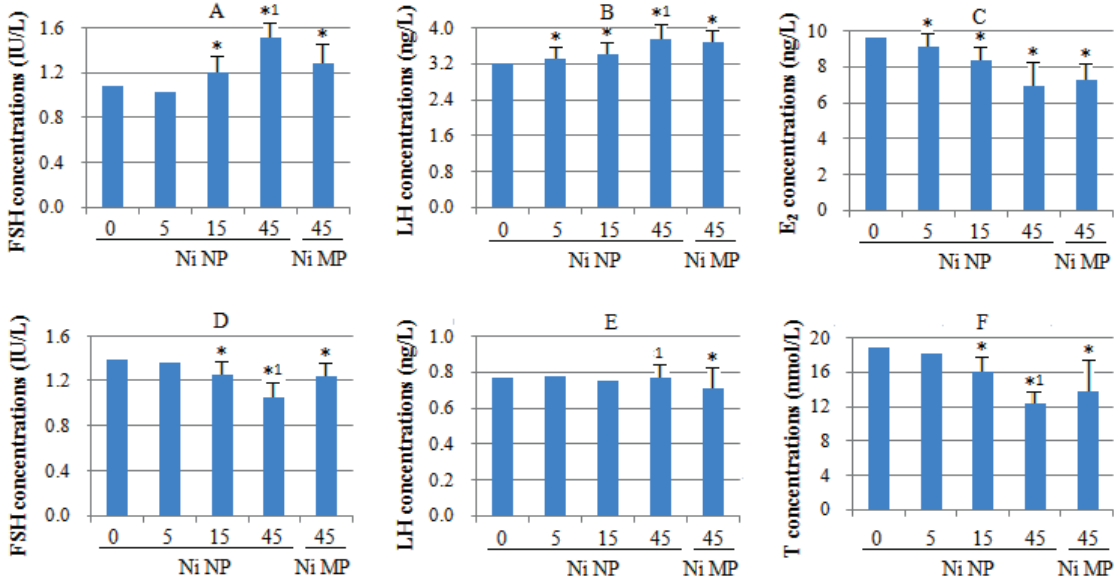
Figure 2. Effects of Ni NPs on serum hormone concentrations in rats. Follicle stimulating hormone (FSH) in females ( A ); Luteinizing hormone (LH) in females ( B ); Estradiol (E 2 ) in females ( C ); FSH in males ( D ); LH in males ( E ); Testosterone (T) in males ( F ). Serum hormone concentrations were measured by ELISA. Values represent the mean ± SD ( n = 7). * p < 0.05, compared with control group (0 mg/kg BW); 1 p < 0.05, compared with Ni MPs (45 mg/kg BW).